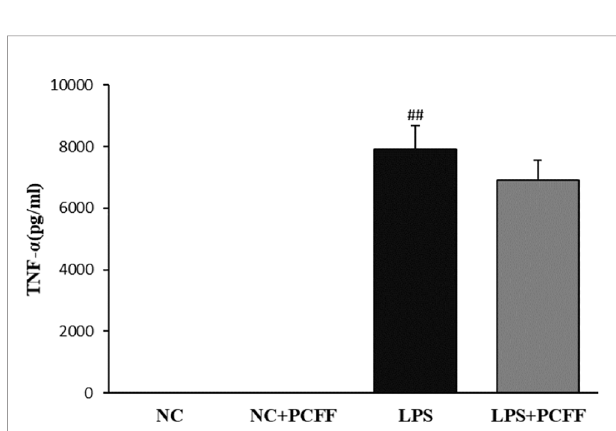
FIGURE 6 | Effect of PCFF on LPS-induced in fl ammatory factor iNOS gene in RAW264.7 cells. Each value indicates the mean ± SD from three independent experiments. Compared with NC group, ## P <0.01; compared with LPS group,